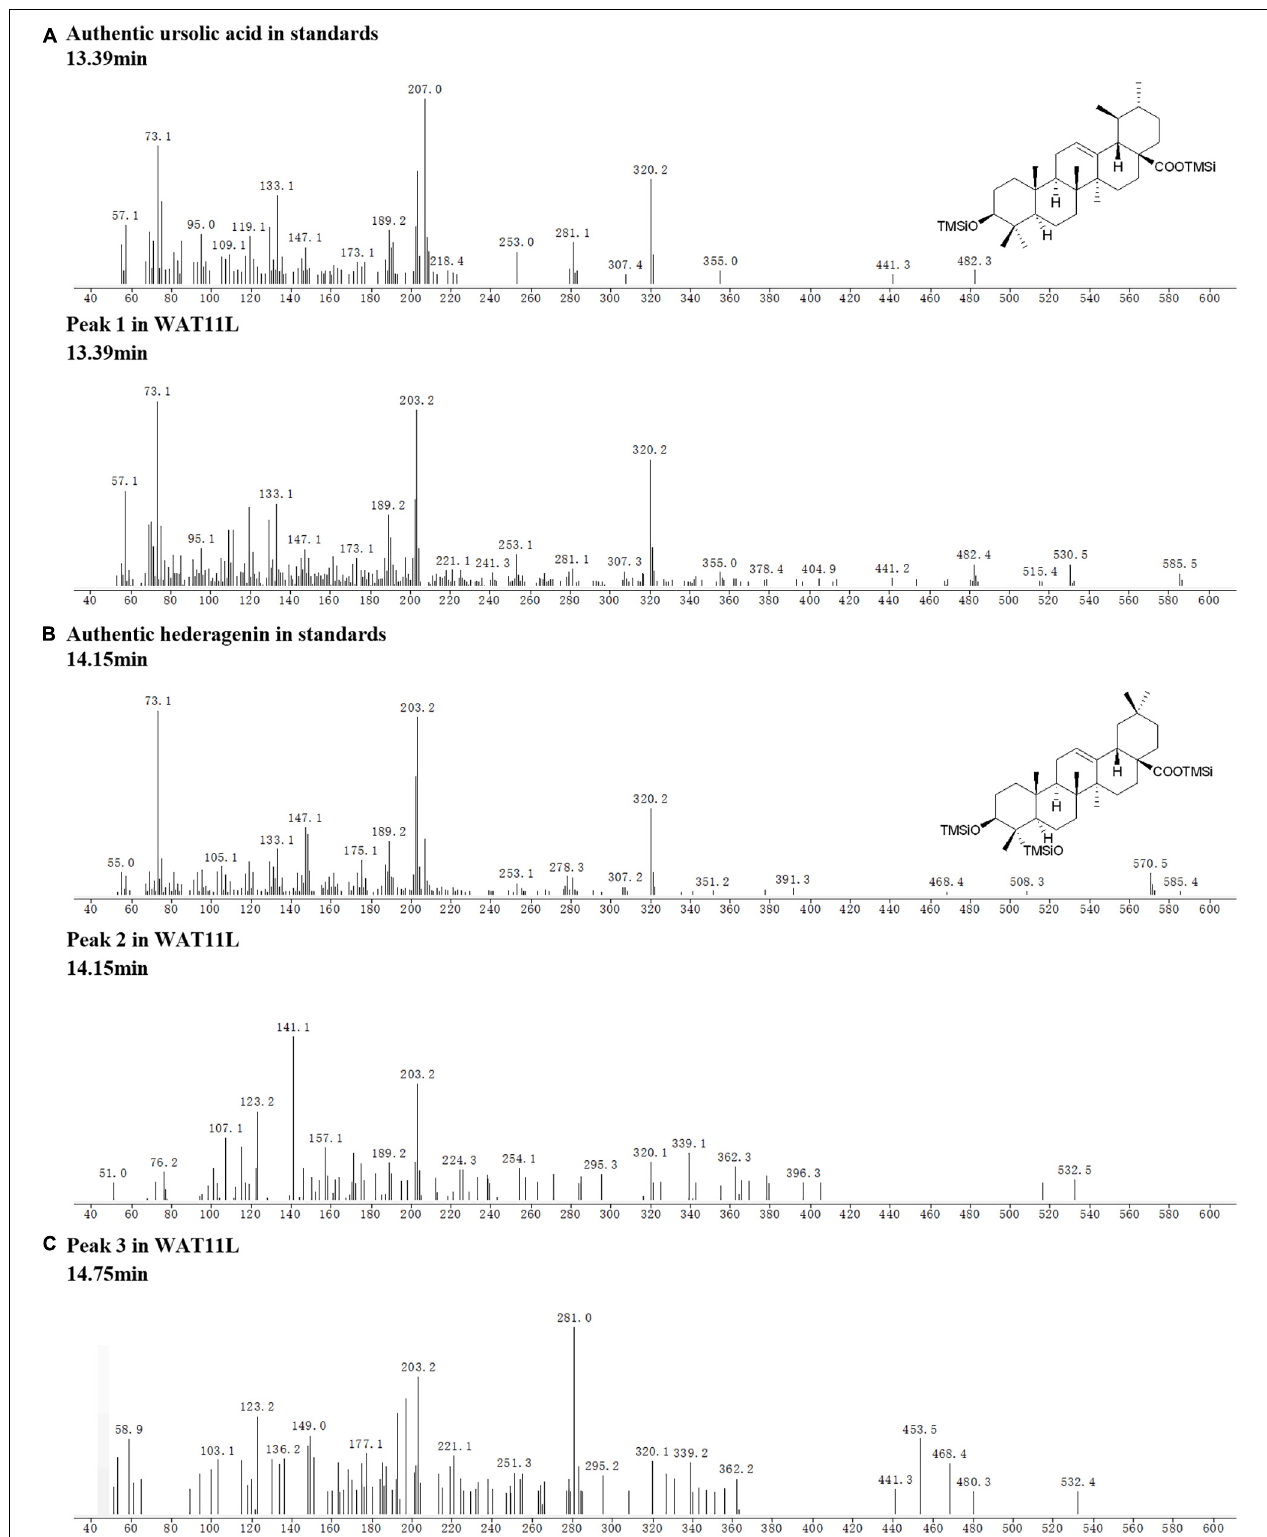
FIGURE 10 | Tentative MS identification of triterpenoids from WAT11L. (A) Compound 1 was tentatively identified as ursolic acid. (B) Compound 2 was tentatively identified as hederagenin. (C) The figure showed the total ion flow diagram of compound 3.